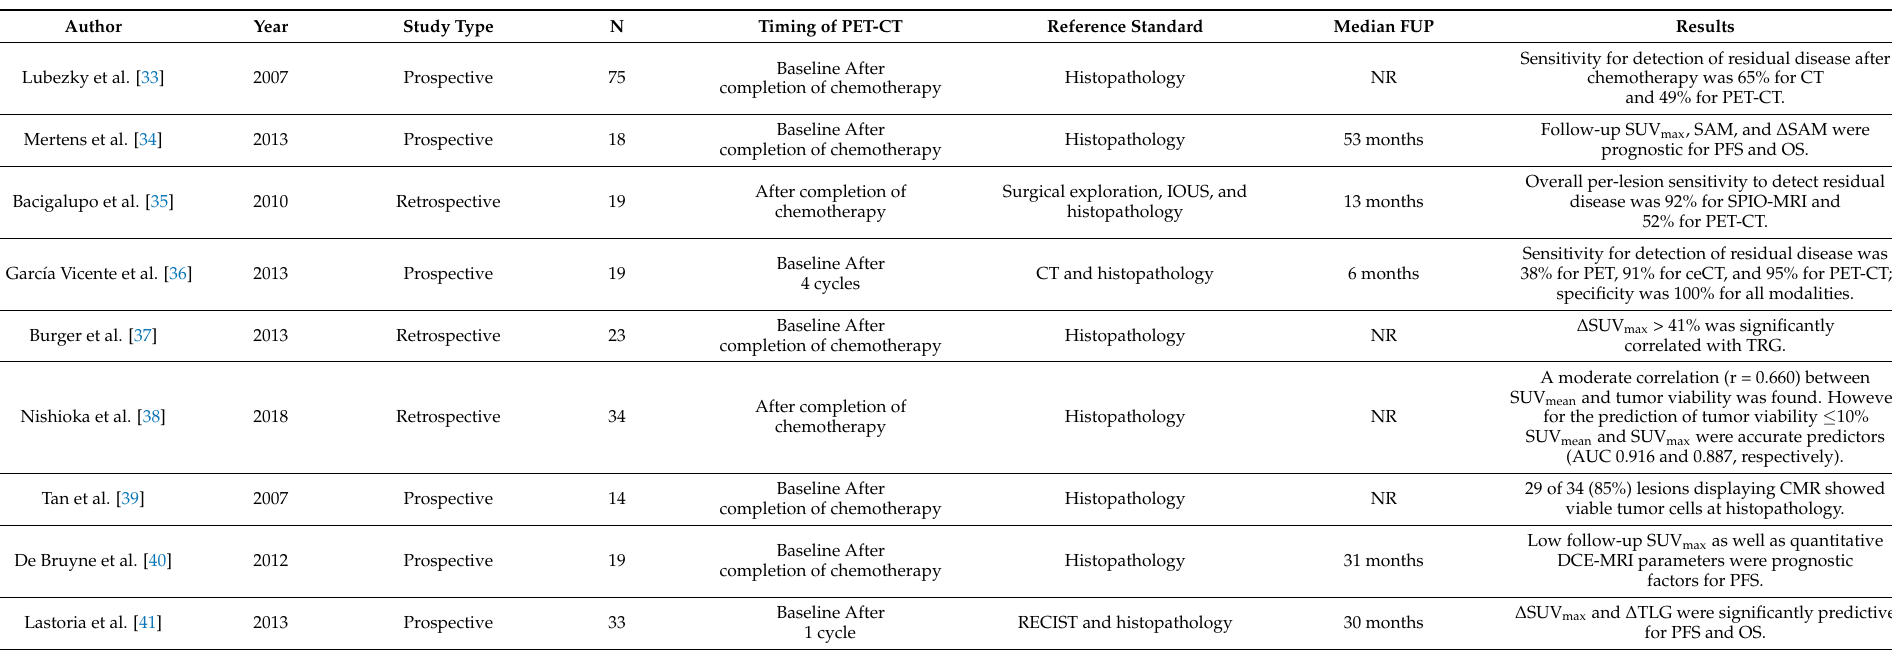
Table 3. Summary of literature studying PET-CT performance after neoadjuvant chemotherapy of colorectal liver